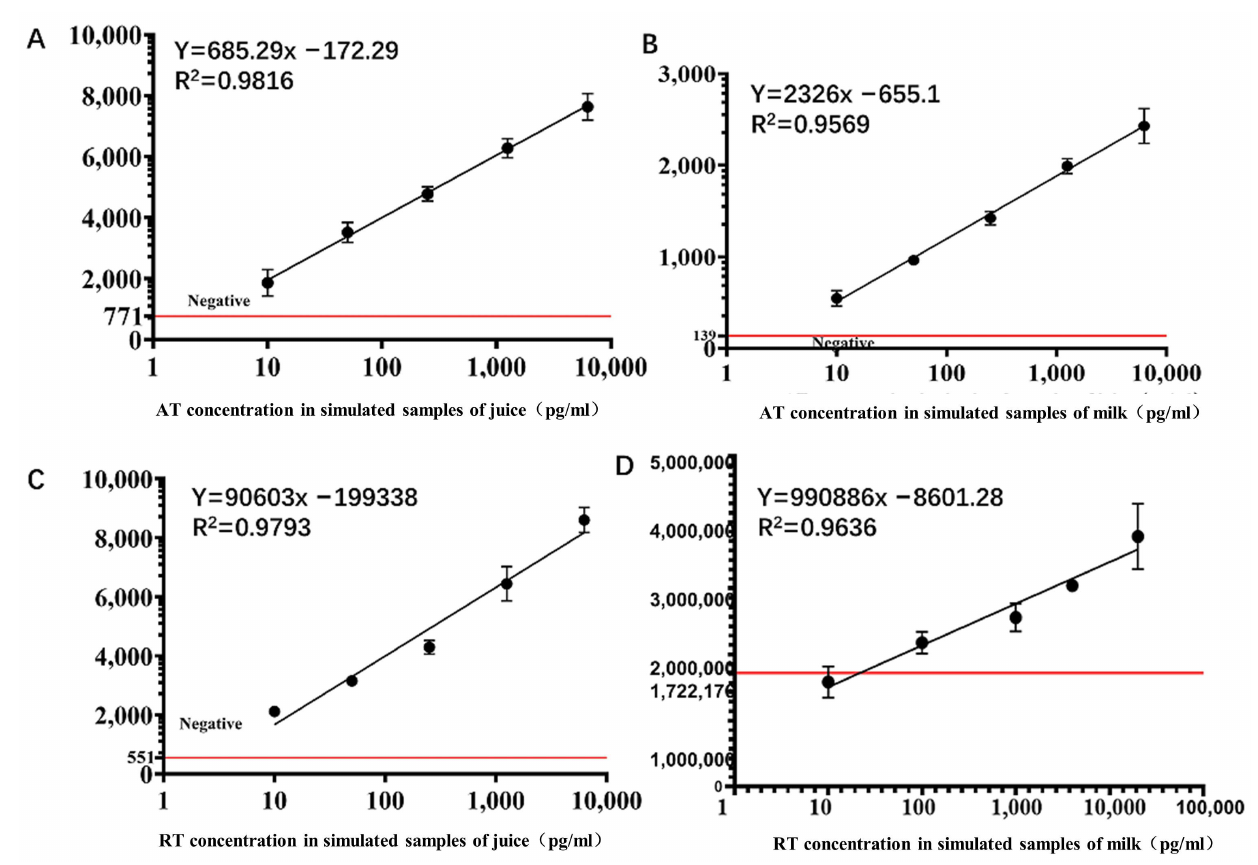
Figure 9. Fluorescence detection curves of ricin and abrin in different food samples. ( A ) AT samples in juice. ( B ) AT samples in milk. ( C ) RT samples in juice. ( D ) RT samples in milk. The red horizontal line represents the boundary between negative and positive